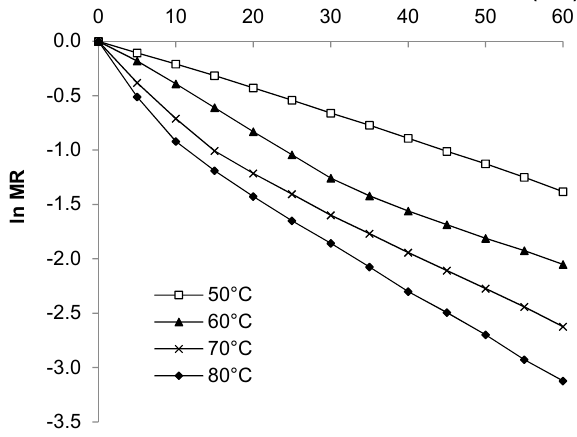
Figure 5. Plots of ln Moisture Ratio versus time for pumpkin seeds dried at constant air velocity of 2.87 m/s.